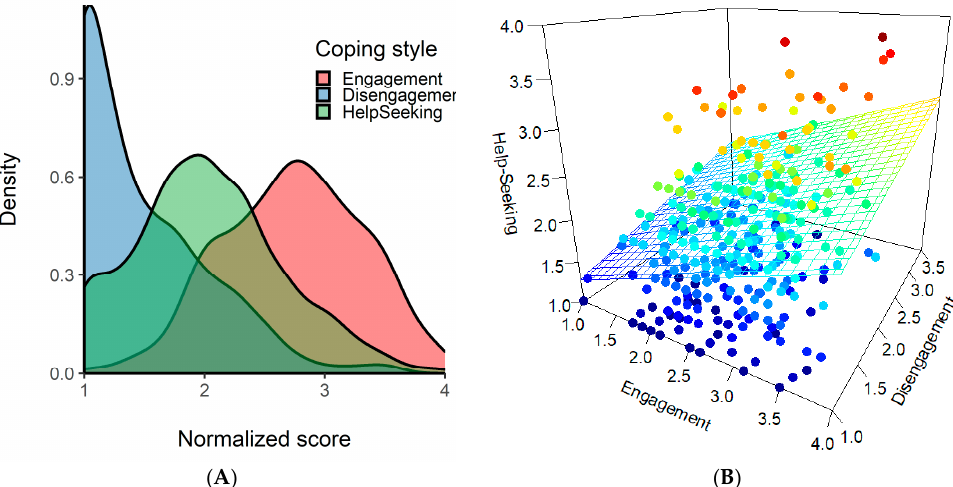
Figure 1. Panel ( A ): density plot of the scores for the three coping styles in our sample. The scores were normalized in the range from 1 to 4. Panel ( B ): 3D scatterplot of the relationship between engagement (x-axis), disengagement (y-axis), and help-seeking (z-axis) coping style. Each point represents a participant and the color of the points maps the help-seeking score, from blue (lower score) to red (higher score). The regression surface represents the relationship of help-seeking with engagement and disengagement styles [49].